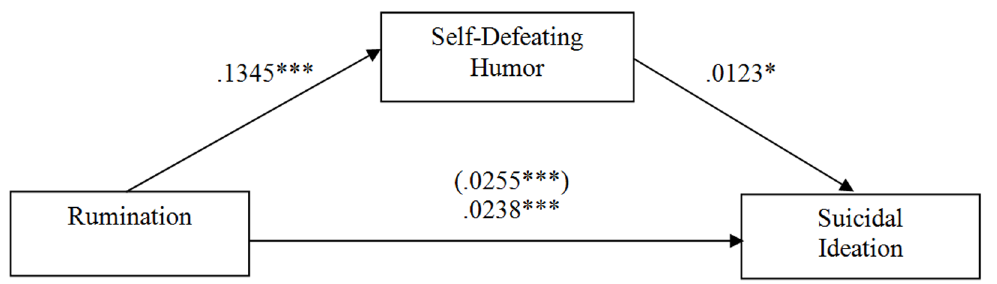
Figure 1. Model of the indirect effect of overall rumination on Suicidal Ideation through Self-Defeating Humor. Note. Numerical values are the unstandardized regression coefficients and the number in parentheses represents the unmediated path.